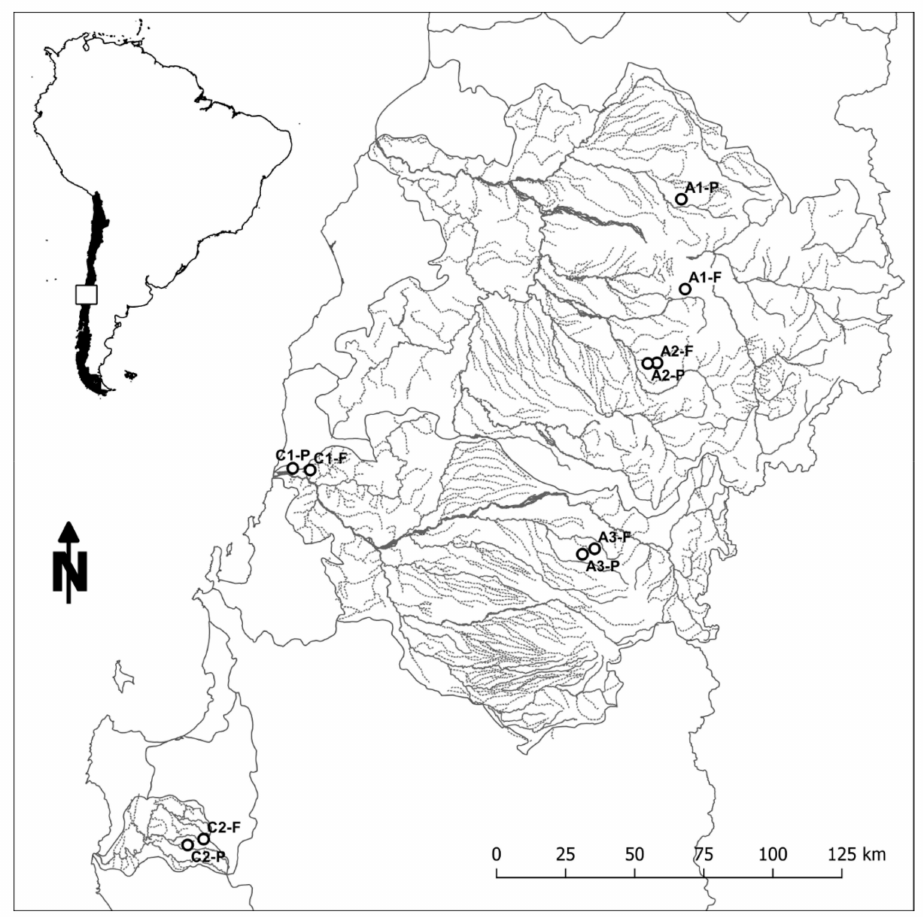
Figure 3. Paired sampling catchments in the uplands of Central Chile. Two pairs (C1 and C2) are located on the Coastal Range, and three pairs (A1, A2, and A3) are located on the Andean Range. Pair designation is based on dominant land use (F: native forest, P: pine plantation). Study area is indicated by the box in the map insert of South